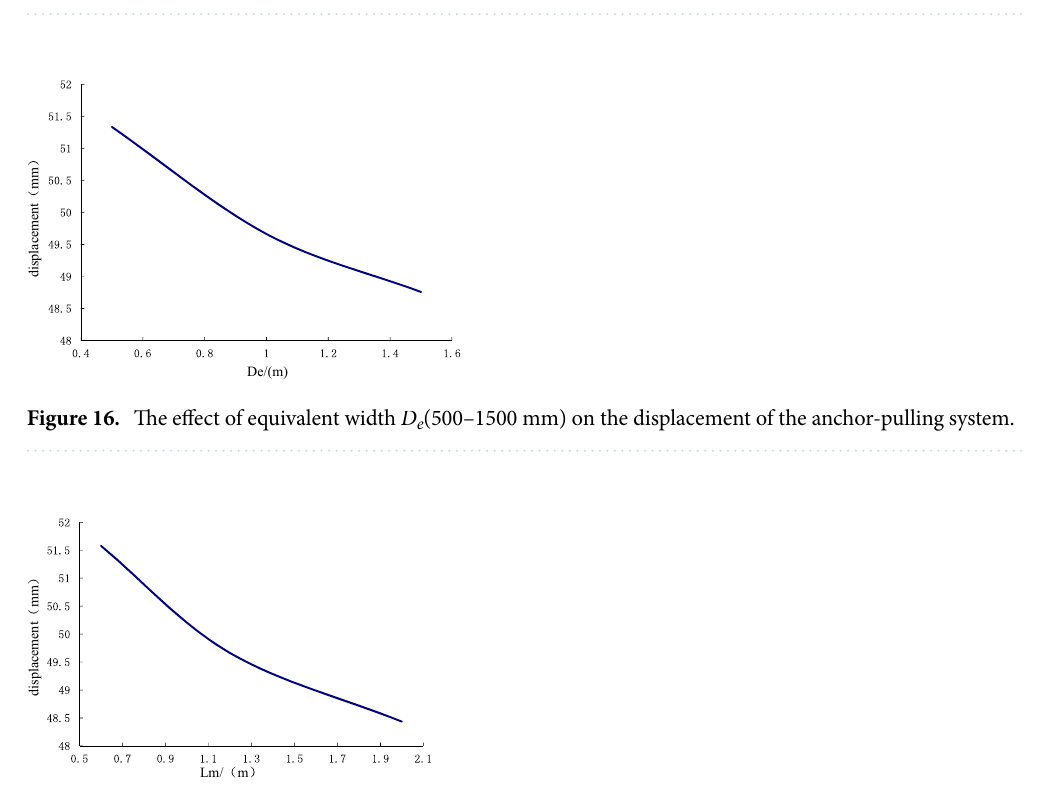
Figure 15. Influence of elastic modulus E (15–45 N/mm 2 ) and Poisson’s ratio µ( 0.15 of anchor system.